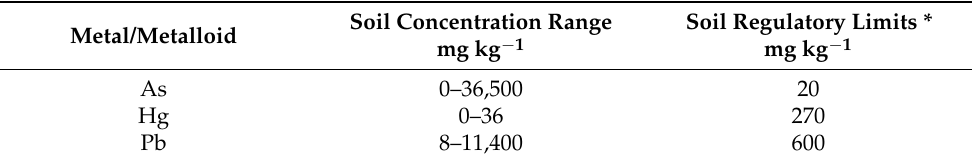
Table 2. As, Hg, and Pb concentrations in the soil samples taken along the Bone River in